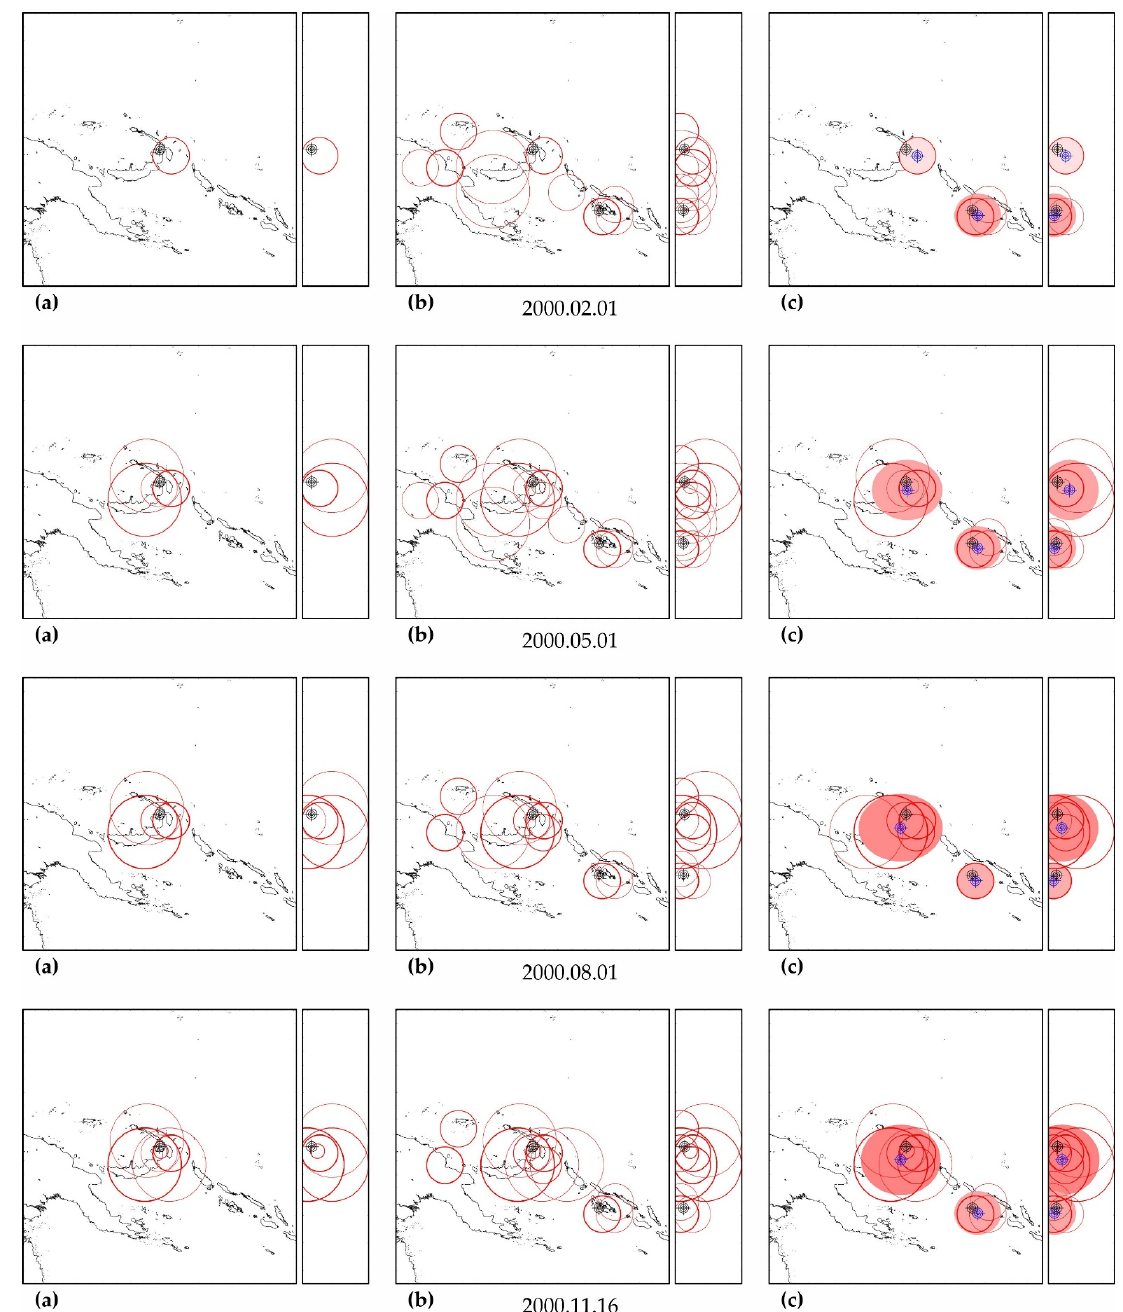
Figure A3. Zones of factual predictability for the earthquake of 16 November 2000 ( a ), identified zones with similar development according to the parameters of the DSDNP equation ( b ) and a cluster of zones of the greatest activity ( c ) used to calculate the time and place of a precedent earthquake. The circles show the position of the zones in which potentially hazardous activity is detected; the thickness of the circle line reflects the number of potentially hazardous trends detected. A double circle with a crosshair is the factual (black) and calculated (blue) positions of the precedent earthquake. The calculated cluster is shown by a solid fill. The cluster color corresponds to the number (the more, the redder) of potentially hazardous unfinished extrapolations found in the cluster. A cluster of predictability of another earthquake (M8.1, 1 April 2007) with a similar foreshock preparation was also found. The size of the maps is 2222 × 2222 km ( ± 10 ◦ latitude from the epicenter of the earthquake). The smaller map to the right of each geographical map is a north–south cross-section with a depth of 750